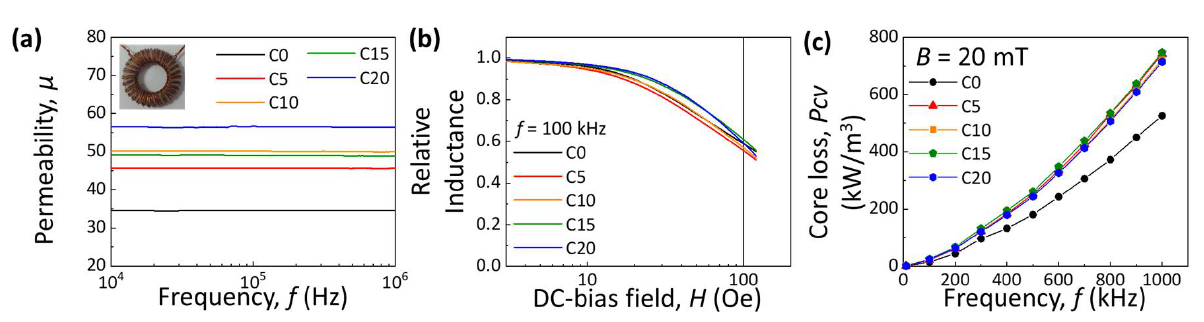
Figure 3. ( a ) Frequency dependence of permeability of amorphous SMCs with 0–20 wt.% CIPs. Inset shows wire-wound core sample. ( b ) Relative inductance (%) with applied DC-bias field for amorphous SMCs with 0–20 wt.% carbonyl-iron. ( c ) Core loss of amorphous SMCs with 0–20 wt.% carbonyl-iron as a function of frequency at B m = 20 mT. Table 2. The coercive field ( H c ) and derived hysteresis loss constant ( K h ) and dynamic loss constant